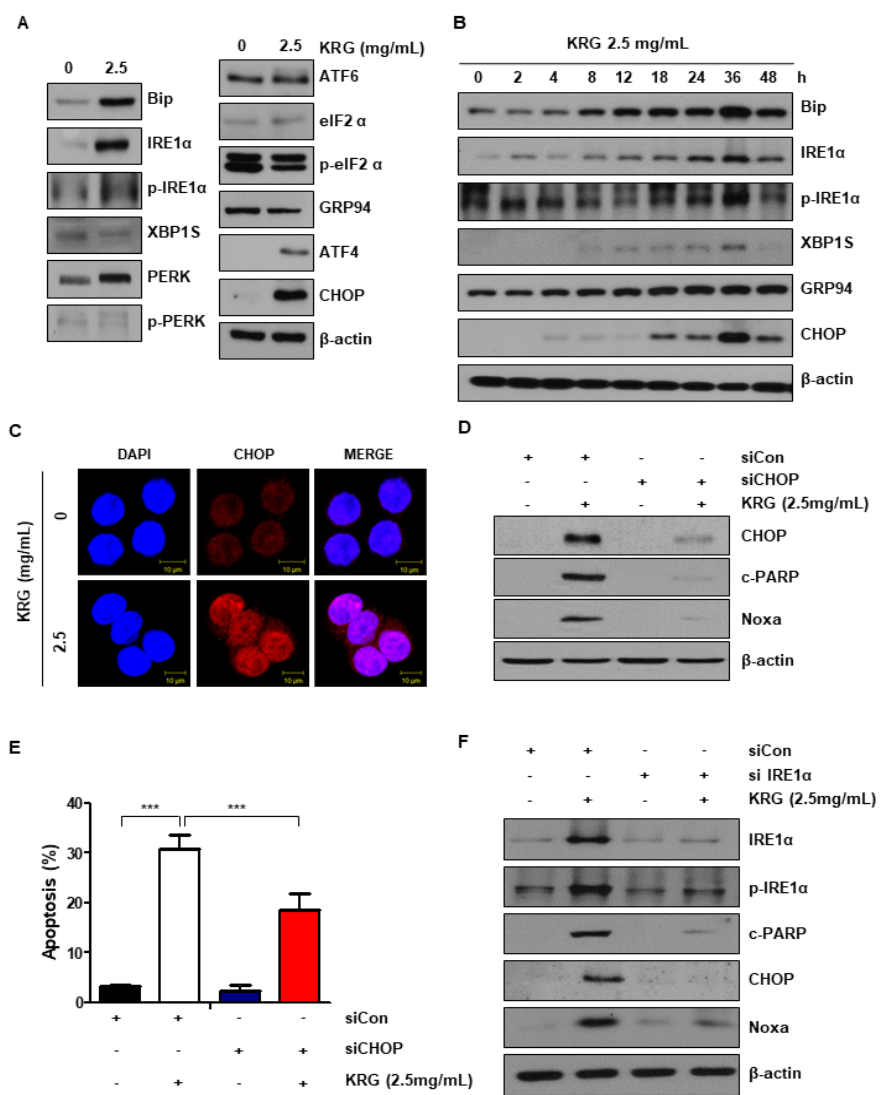
Figure 3. KRG extract induced the activation of ER stress. ( A ) HT29 cells were treated with KRG extract (2.5 mg/mL) for 24 h. The expression levels of Bip, IRE1 α , p-IRE1 α , XBP1s, PERK, p-PERK, ATF6, eIF2 α , p-eIF2 α , GRP94, ATF4, and CHOP (ER stress-related proteins) were observed by western blotting. ( B ) The level of the ER stress markers was measured by western blotting for the indicated times. ( C ) CHOP expression was assessed by immunofluorescence and confocal microscopy.